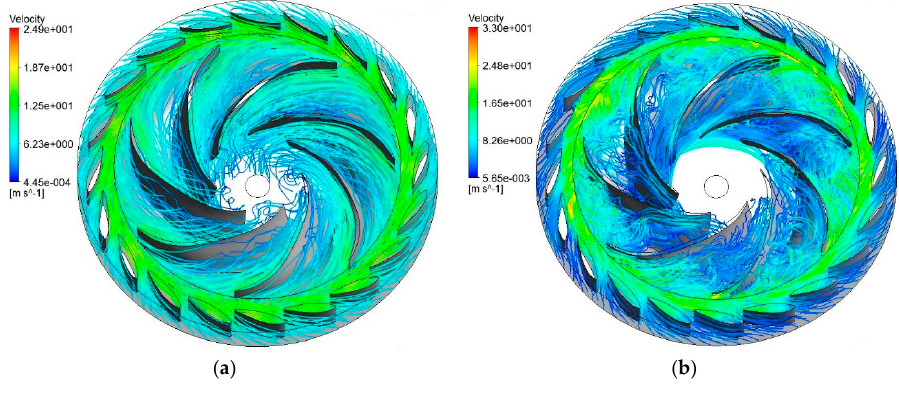
Table 8. Amplitude and dominant frequency of pressure fluctuations at GV5.